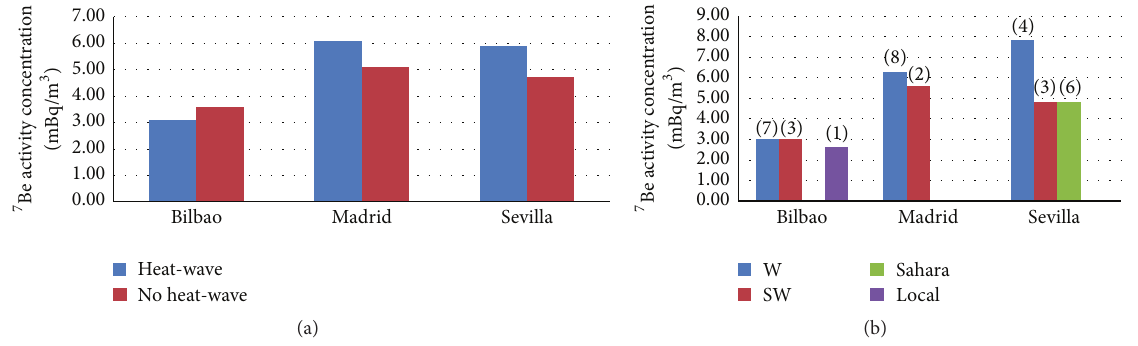
Figure 6: Comparison of 7 Be activity concentration in each sampling site observed during (a) the whole set of heat-wave events and the remaining 7 Be values registered during the same month and (b) the contribution of each air mass circulation considering the “pure” heat- waves events. In brackets is the number of pure heat-wave events associated with each 7 Be activity concentrations. W: westerly and SW: